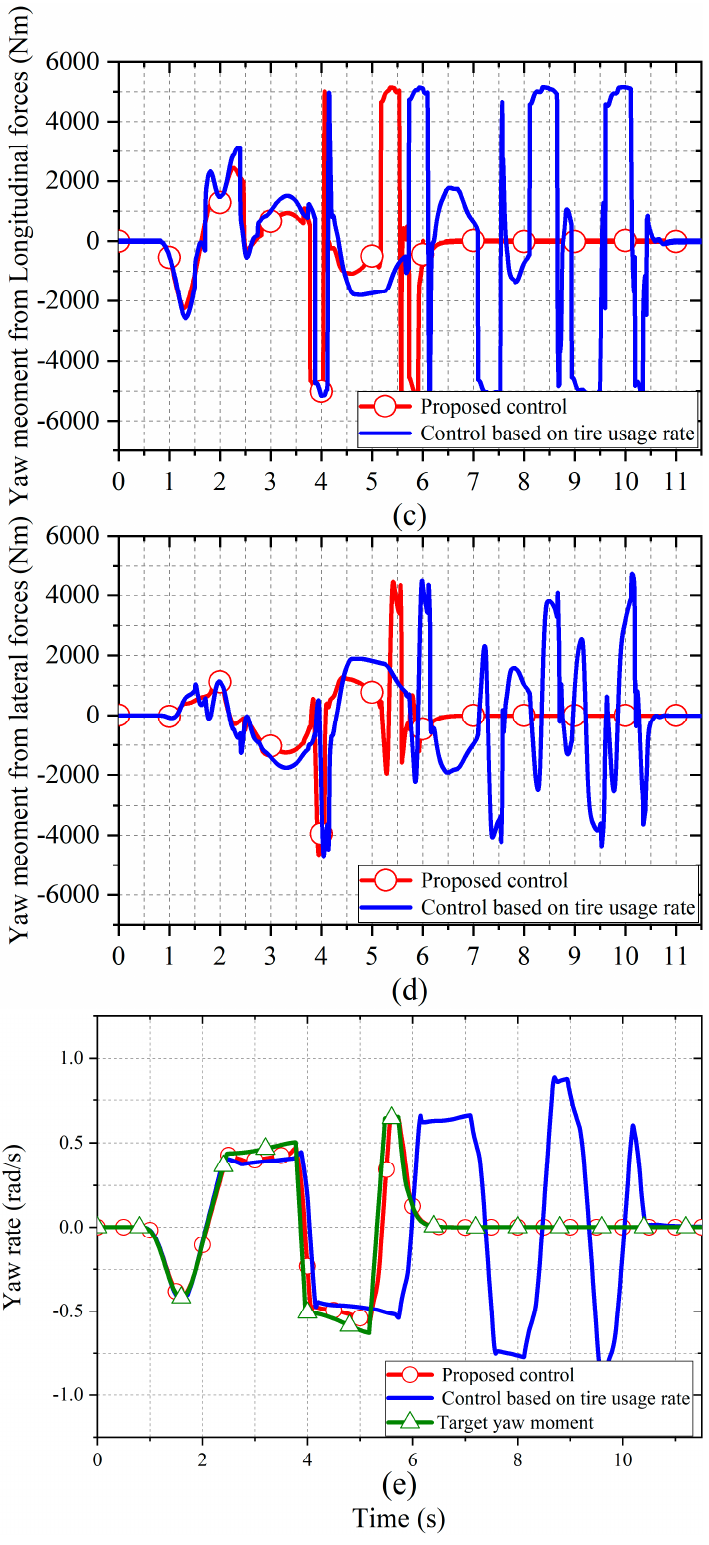
Figure 7. Comparison of the simulation results between the vehicle with the use of the proposed control and the optimal tire usage rate control: ( a , b ) front − left and rear − right motor driving forces; ( c , d ) center of gravity (CG) yaw moment from the motor driving forces and the lateral tire forces; ( e ) yaw rate responses.